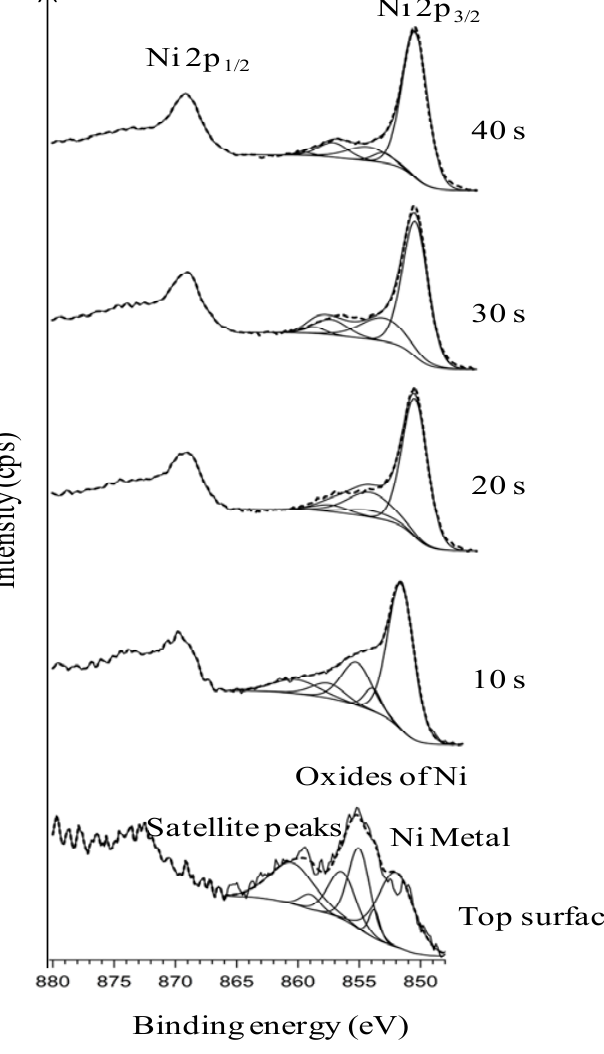
Figure 5. XPS depth profile studies of Ni peaks in substrate chemically cleaned with etching for 15 min (with deconvolution for the presence of